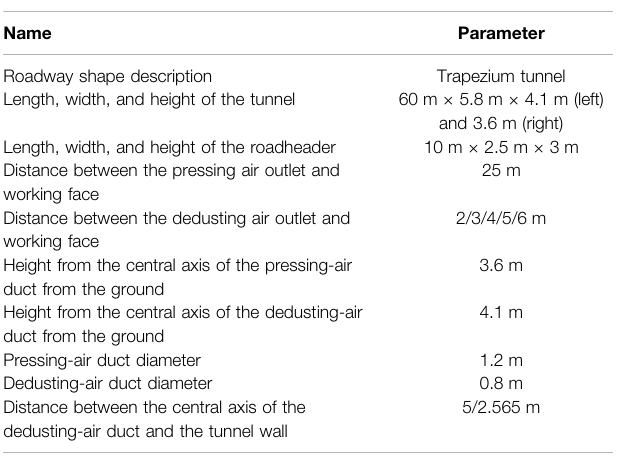
TABLE 1 | Physical model parameters of the working face in the Shoushan Coal Mine.